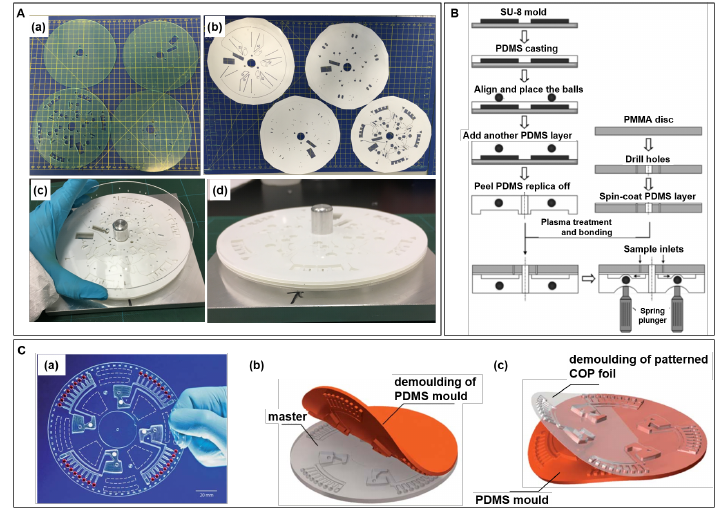
Figure 4. ( A ) Photographs of steps of layers assembly during the LoaD manufacture: ( a ) laser ablation cut PMMA discs, ( b ) knife-cut PSA layers, ( c ) stacking and alignment of layers, and ( d ) side view during the mounting of layers. ( B ) Schematics of PDMS moulding to fabricate the disc: Pinch valves-based disc fabricated by PDMS moulding. Reproduced from [57] with permission from Elsevier. ( C ) Hot embossing fabricated LoaD biosensor: ( a ) photograph of the LoaD, ( b ) fabrication of the PDMS mold using a milled PMMA master, and ( c ) demoulding of the hot embossed COP foil. Reproduced from [67] with permission from The Royal Society of